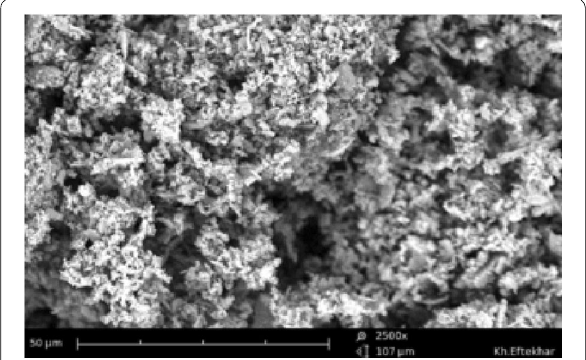
Fig. 1 The SEM image of mesoporous silica sample with magnification of 2500 ×